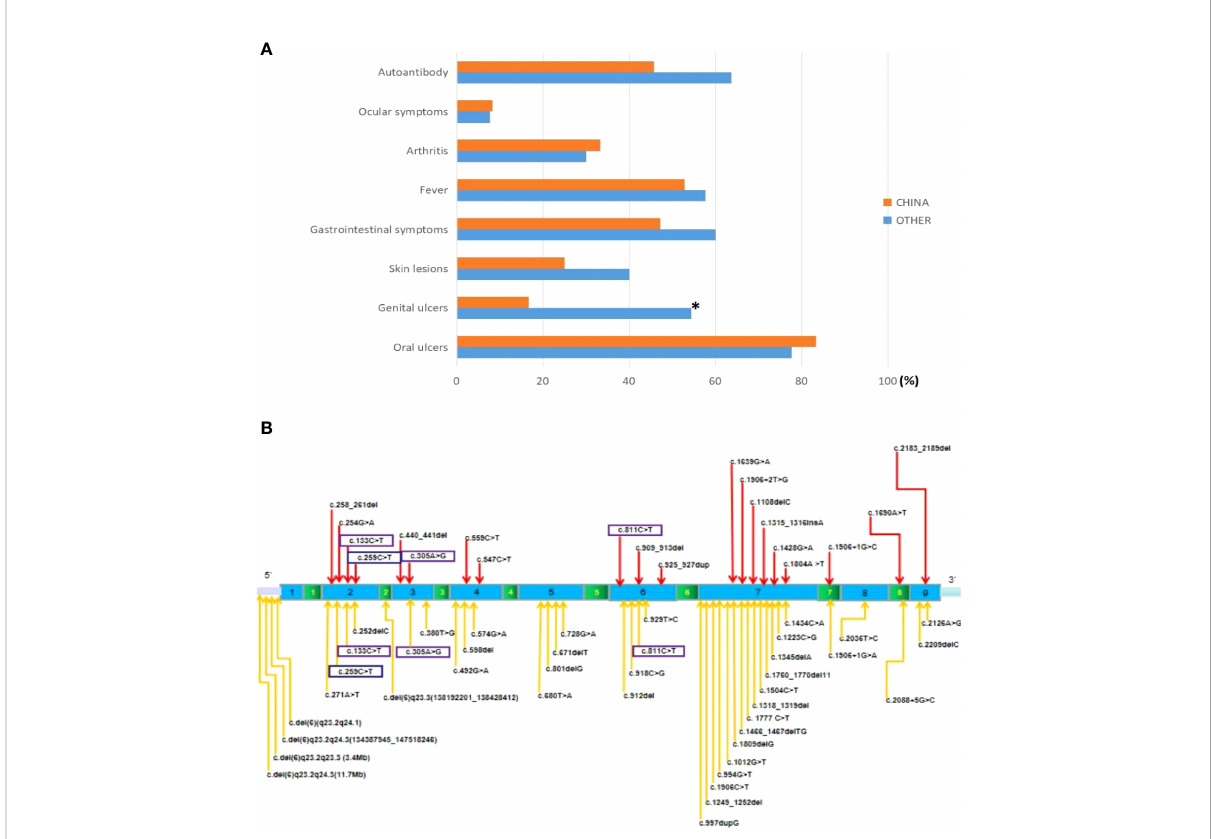
FIGURE 3 (A) Comparison of clinical phenotypes of HA20 patients in China and other populations. *P<0.05. (B) The locations of variants in the TNFAIP3 gene. The red arrows represent the locus of variants in the Chinese (20). The orange arrows represent the locus of variants from other populations (41). The purple boxes represent co-owned variants